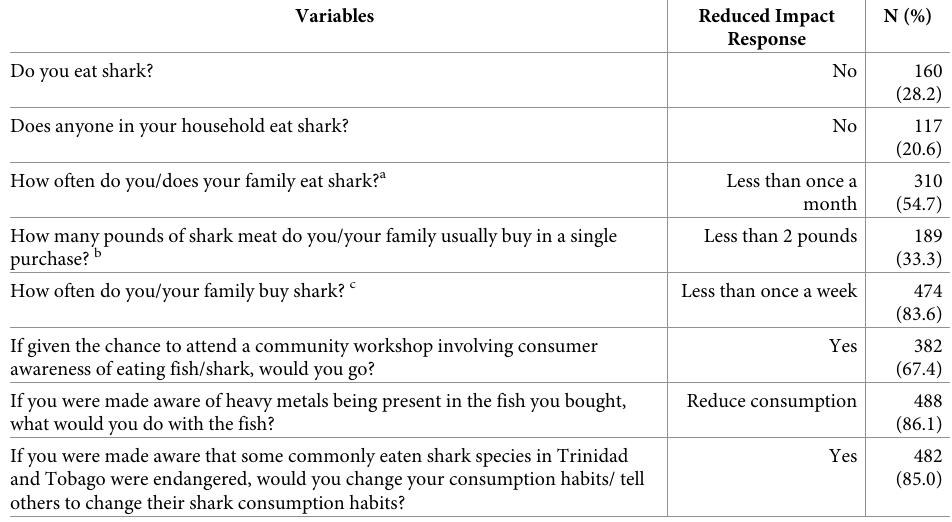
Table 3. Number and percentage of participants who had good and poor practices regarding shark consumption. Variables Reduced Impact